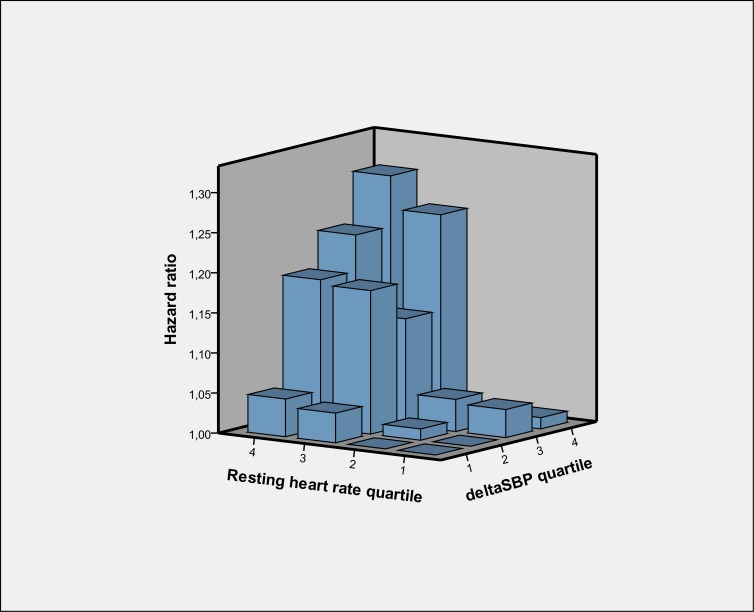
Quartile specific hazard ratios concerning resting heart rate and orthostatic change in systolic blood pressure (SBP) in relation to first incident low-energy fracture.Hazard ratio = 1.00 (reference) for quartile 1/1 of resting heart rate/ΔSBP. Model includes covariates age, sex, body-mass-index, antihypertensive treatment, smoking, diabetes, previous myocardial infarction, SBP in supine. Results are detailed in S3 Table.